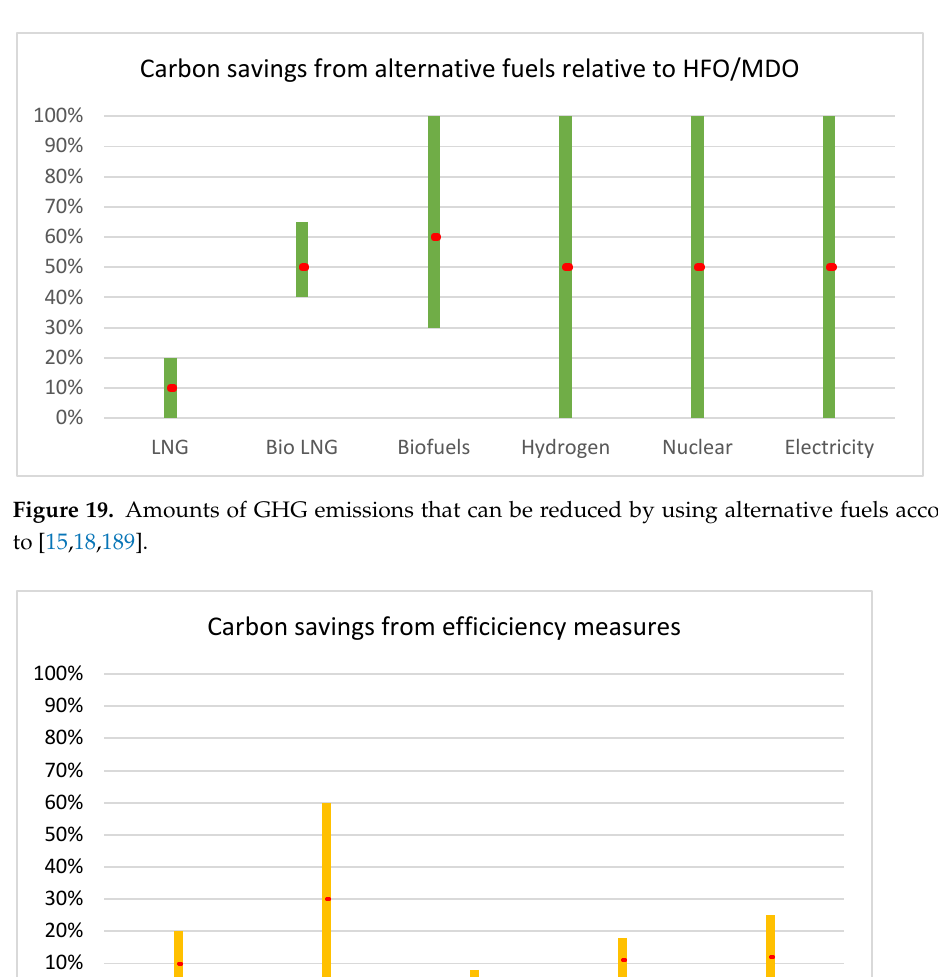
Figure 19. Amounts of GHG emissions that can be reduced by using alternative fuels according to [15,18,189].